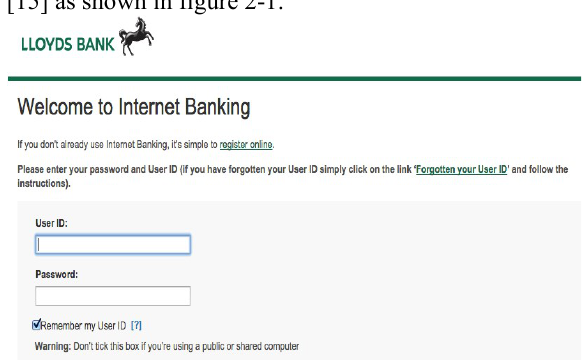
Figure 2-1: User ID and Password.